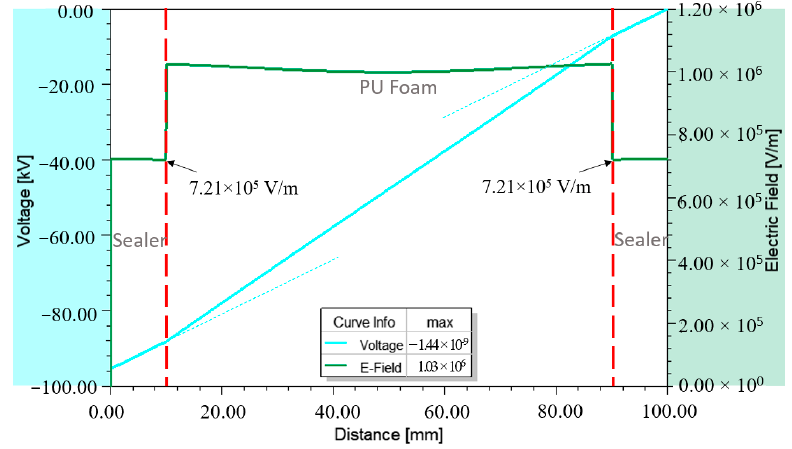
Figure 15. Voltage distribution versus E ‐ field distribution across X3.